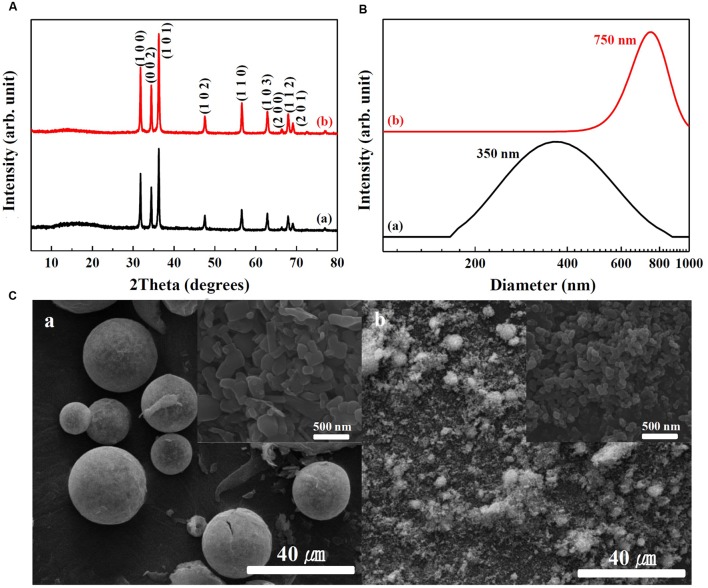
(A) XRD patterns, (B) hydrodynamic radii measured by DLS, and (C) SEM images of (a) SunActive ZnTM and (b) ZnO-NPs. Insets in (C-a,b) are magnified images at the surface of materials.